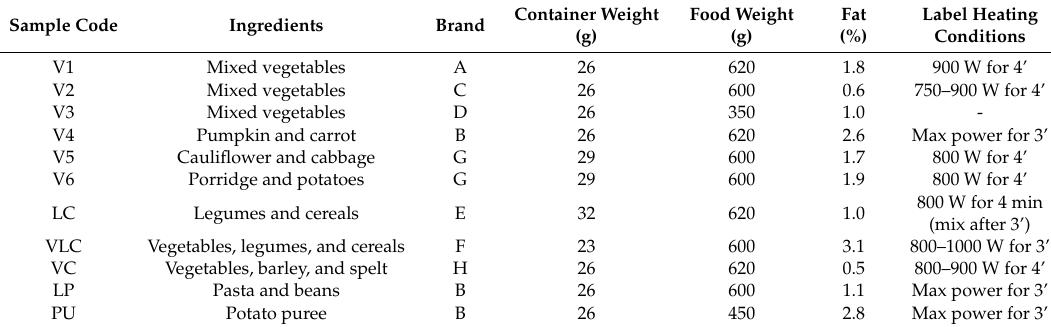
Table 1. Description of food